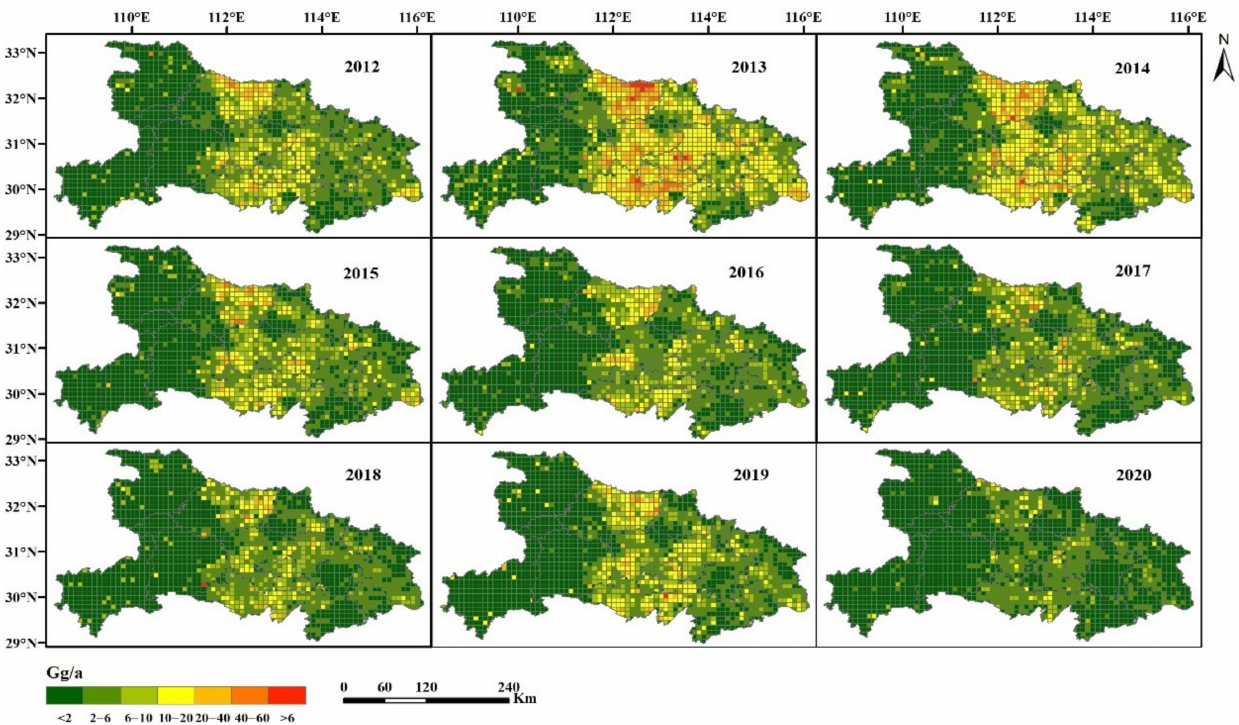
Figure 5. The spatial distribution of CO 2 emissions in Hubei from 2012 to